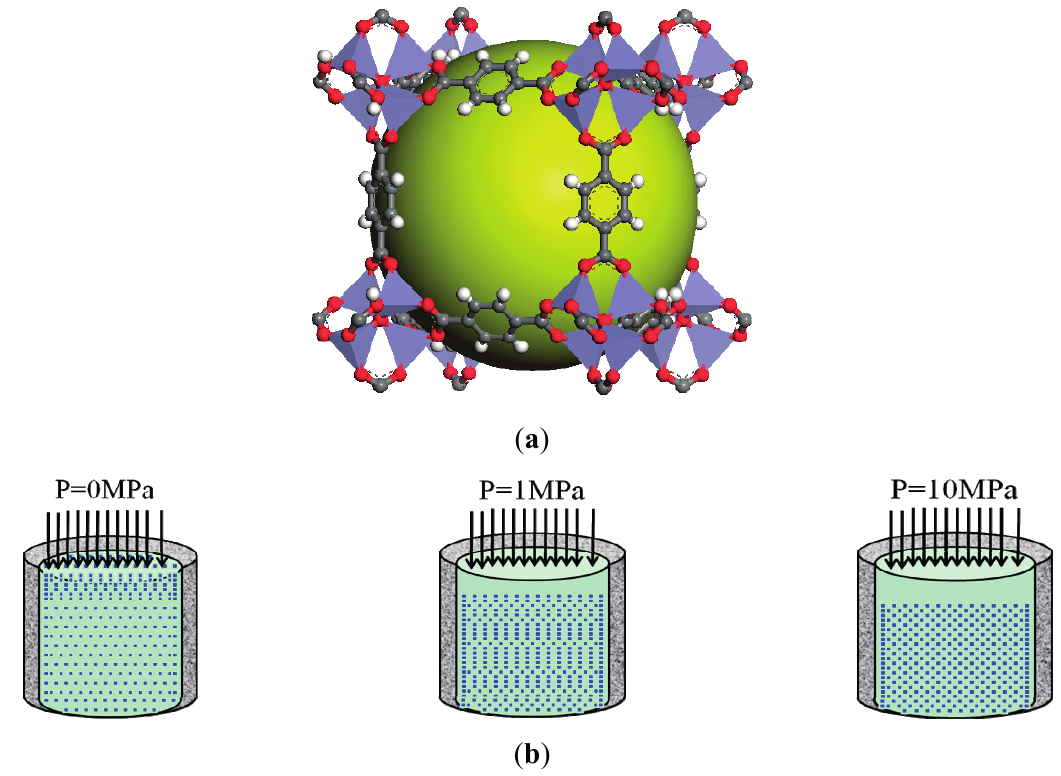
Figure 1. Structure of MOF-5 crystal and varying porosity at different pressures. ( a ) Structure of MOF-5 and its topology (ZnO 4 tetrahedral: blue polyhedra; benzene dicarboxylate linkers: O, red and C, black; pore: yellow sphere); ( b ) Varying bed porosity at different